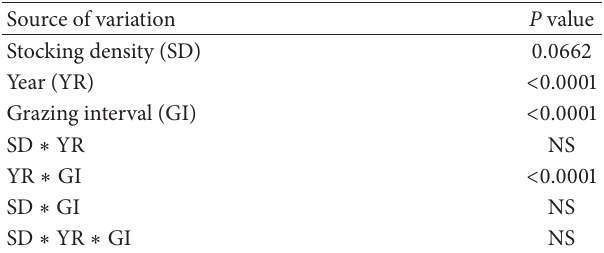
Table 9: Analysis of variance for average daily gain by stocking density, grazing interval, year, and their